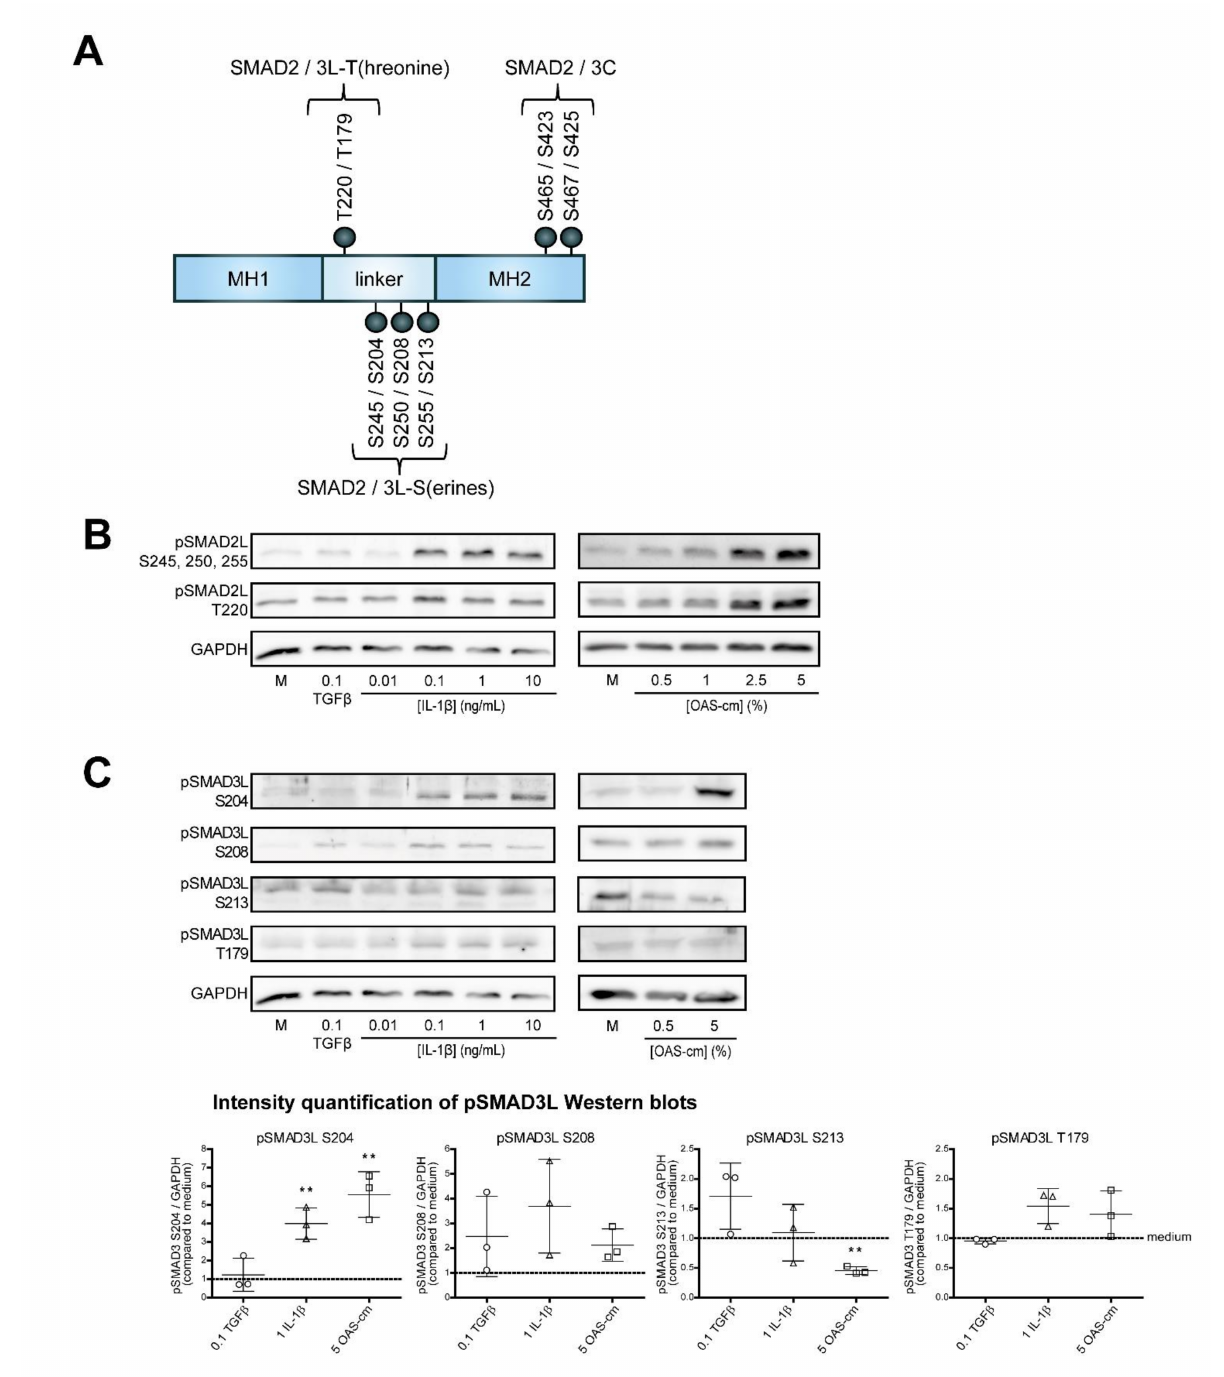
Figure 4. OA-related inflammation (de)phosphorylates the SMAD 2/3 linker region. SMAD proteins can also be post- translationally phosphorylated at serine and threonine residues within their linker (L) region: SMAD2 at threonine (T) 220 and serines (S) 245, 250, 255 and SMAD3 at the corresponding T179, S204, S208 and S213. ( A ) Schematic illustration of the SMAD2 and SMAD3 proteins and their phospho-epitopes in the linker (L) region and C-terminus. ( B , C ) Chondrocytes were treated for 1 h with 0.1 ng/mL TGF- β or with different concentrations of IL-1 β (0.01–10 ng/mL) or OAS-cm (0.5–5%) and subsequently phosphorylation at the different phospho-sites in the linker region of SMAD2 ( B ) and SMAD3 ( C ) were visualized on Western blot. Quantification of the Western blots was performed with ImageJ. Data are presented as dot plots with mean ± SD, with each dot representing one donor, n = 3. GAPDH was used as loading control. Statistics were performed using two-tailed Student’s paired t -test: ** p ≤